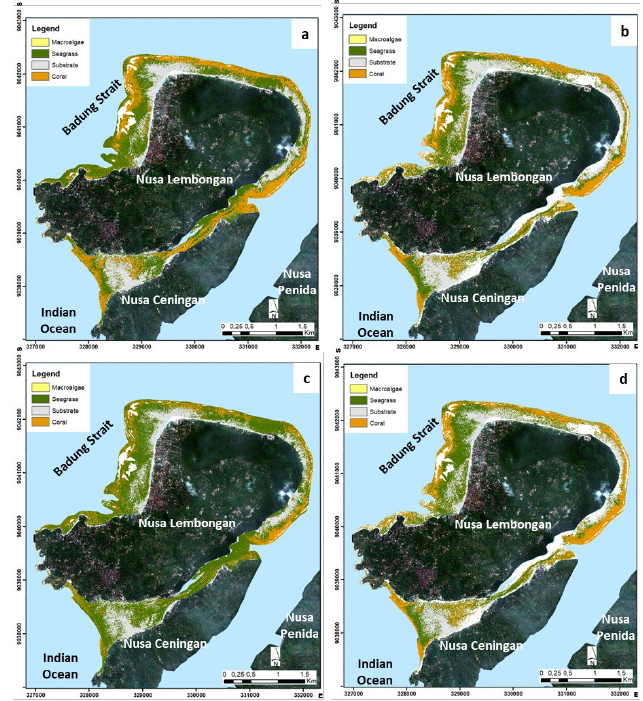
Figure 4 . Benthic spatial maps (a) Scenario 1, (b) Scenario 2, (c) Scenario 3, dan (d) Scenario